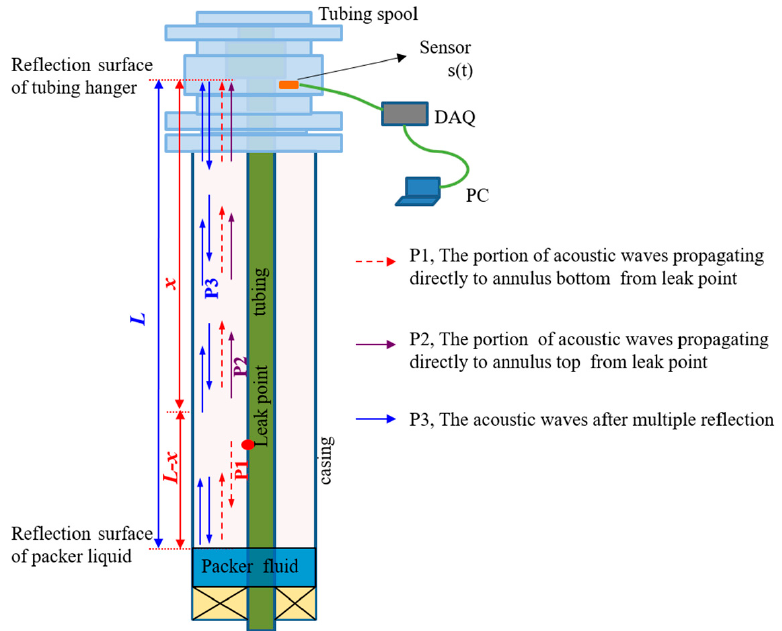
Figure 2. Schematic of the mechanism for tubing leakage localization based on the acoustic method.